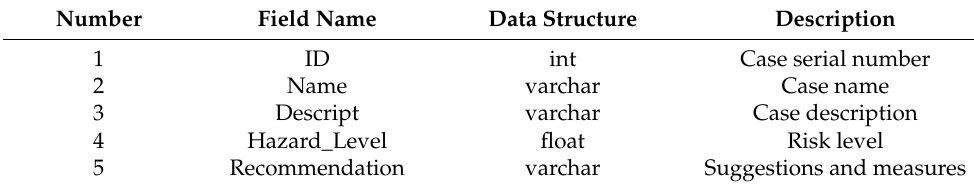
Table 7. The Case Information table.